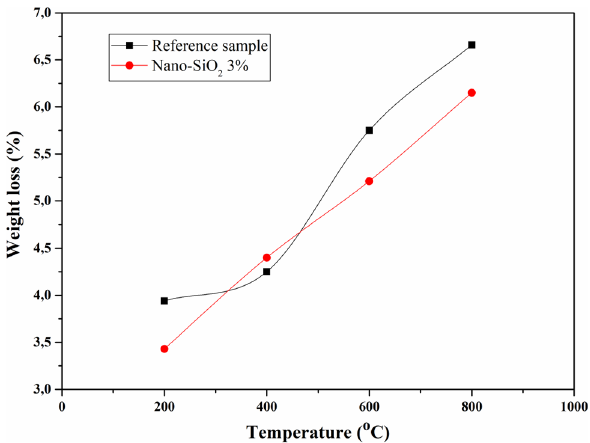
Fig. 5 Variation of slump of concrete with substitution level of nan- oparticles: (1): nano-CaCO